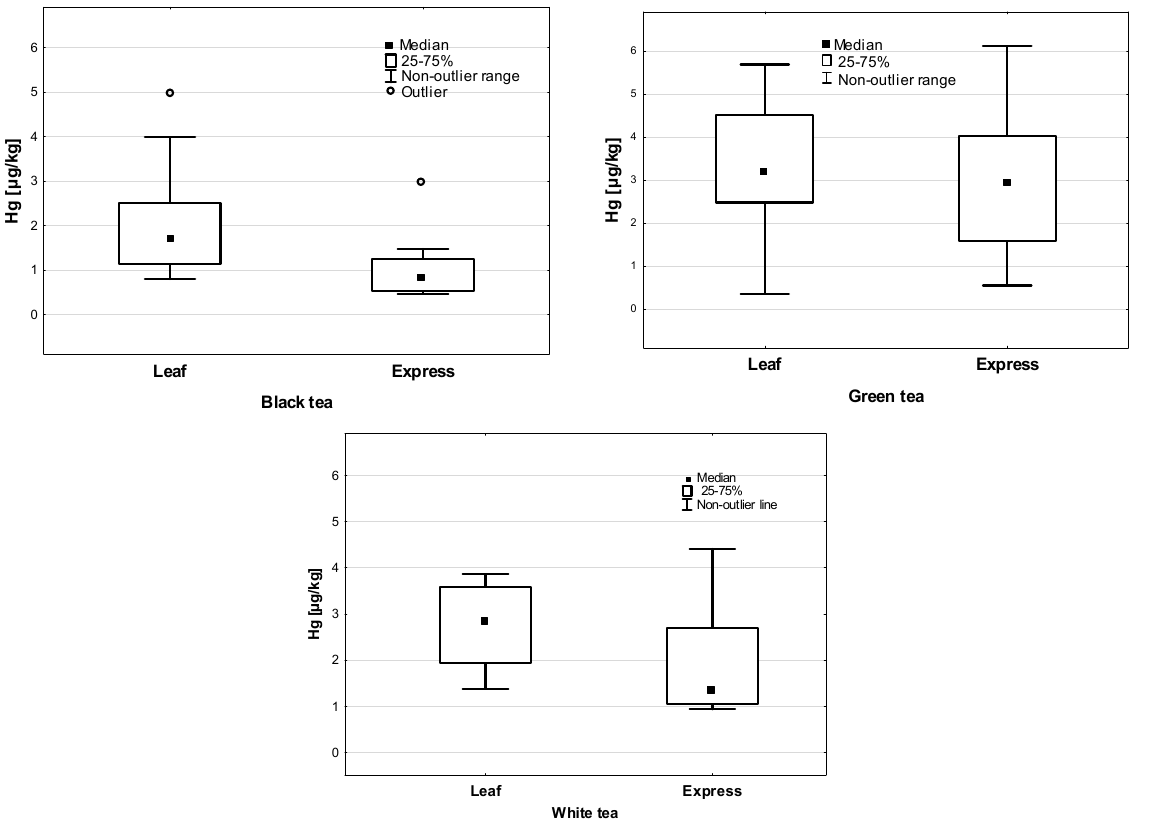
Figure 3. Hg concentration in different kinds of leaf and express tea ( μ g/kg). Taking into account the type of tea in this comparison, statistically significant differ- ences occurred only in the case of the tested green tea samples (2.55 µ gHg/kg—tea with additives and 4.09 µ gHg/kg—pure tea). Similarly, in the case of Yerba Mate, additional substances supplementing the composition significantly ( p = 0.002) influenced the increase in the Hg concentration in the tested samples (8.28 vs. 5.14 µ gHg/kg)—Figure